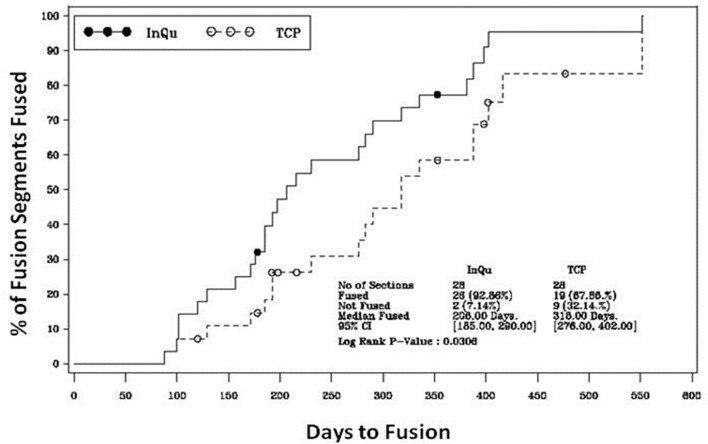
Kaplan–Meier analysis of time-to-fusion. The log-rank test of the homogeneity of the Kaplan–Meier curves showed that the time-to-fusion for the InQu-treated side at 206 days was significantly (p < 0.0309) shorter than the β-TCP curve at 318 days.